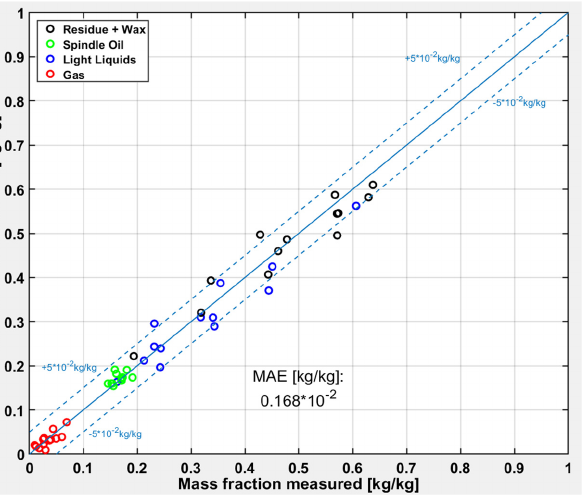
Figure 10. Deviation of the modeled and measured values of the test runs with carrier fluid and LDPE. “MAE” is the mean absolute error of the optimization of 0.17 × 10 − 2 kg/kg. The dashed lines show the 10% deviation.